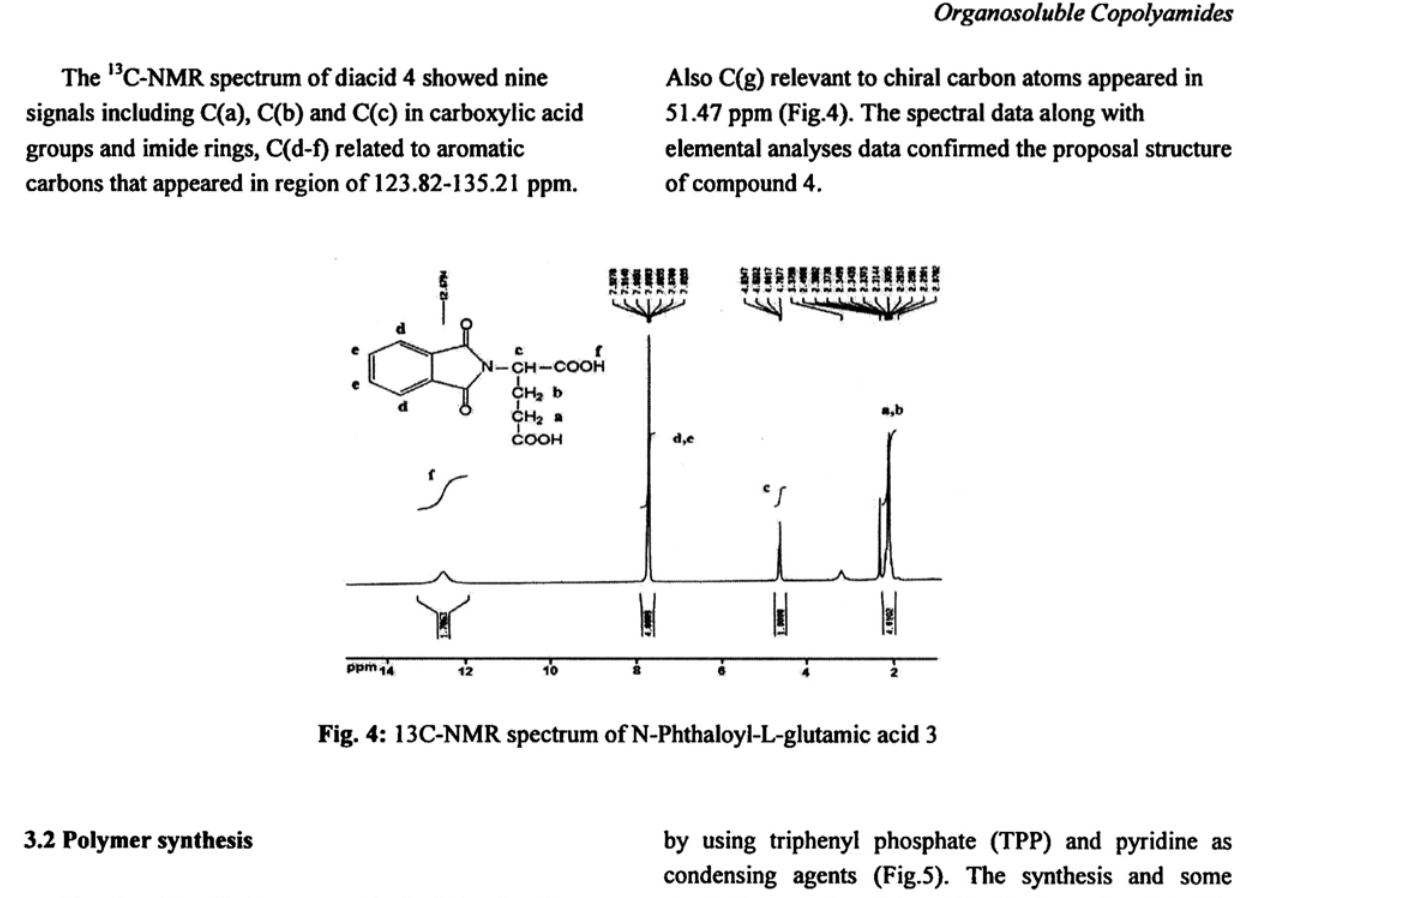
Fig. 4: 13C-NMR spectrum of N-Phthaloyl-L-glutamic acid 3